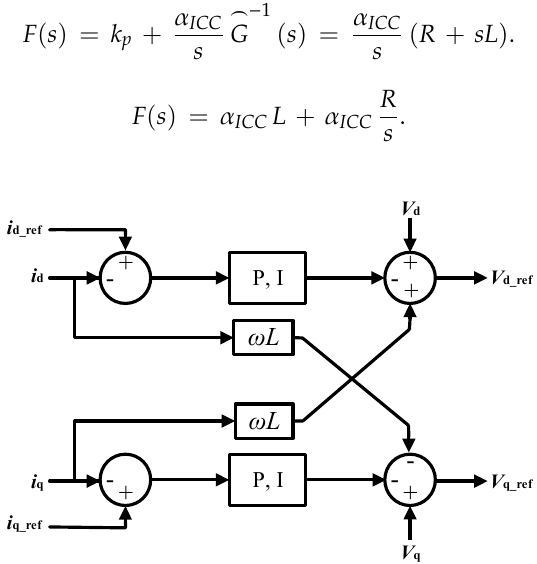
Figure 3. Inner current control loop of SST-VSC.